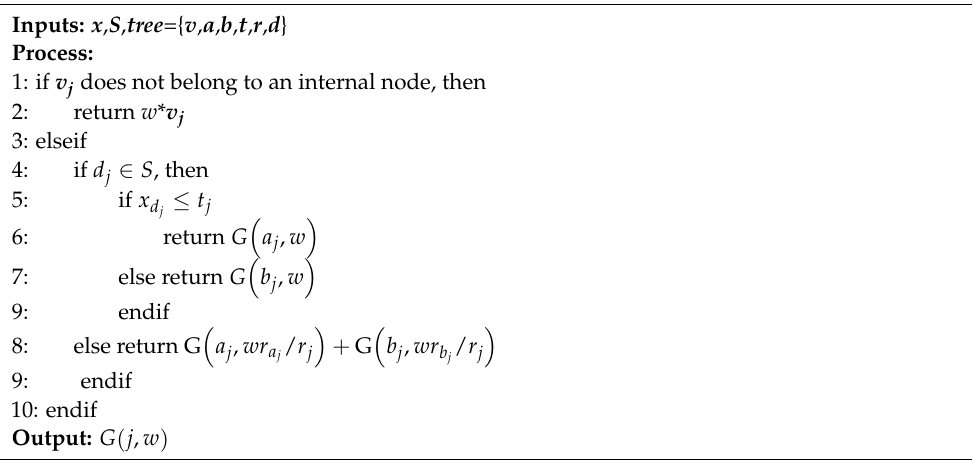
Algorithm 1: SHAP Tree Model Shapley Value Calculation Pseudo-Code E [ f ( x ) | x S ]